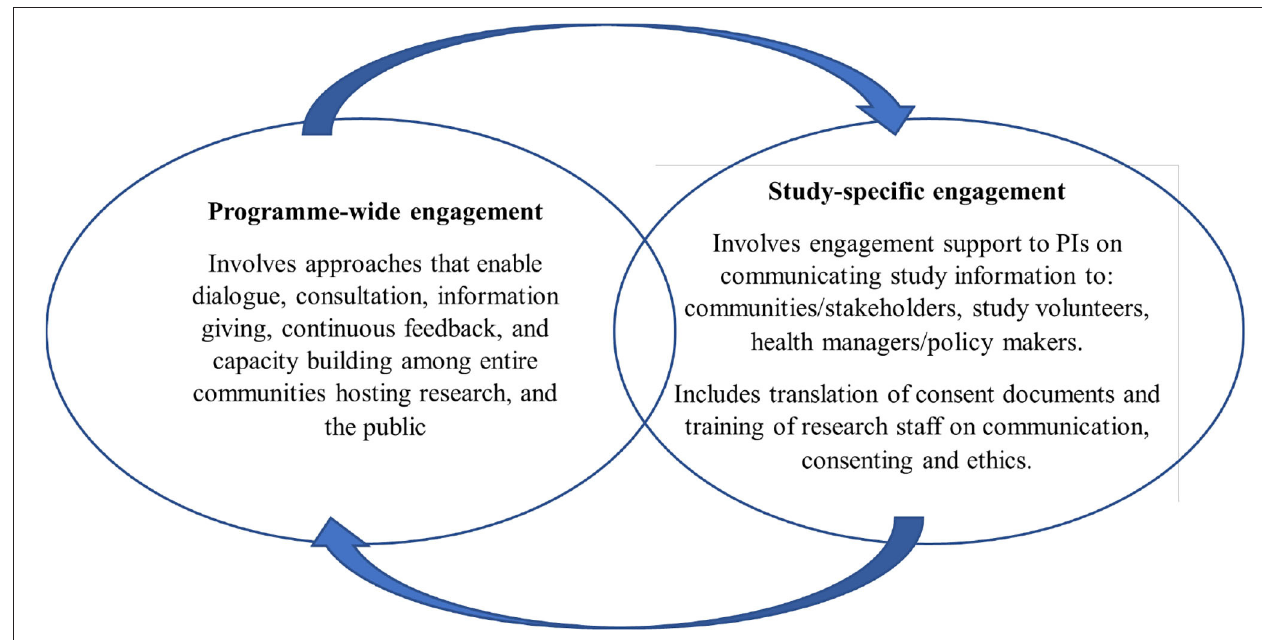
FIGURE 1 | Programme-wide and study-specific community engagement at KWTRP.